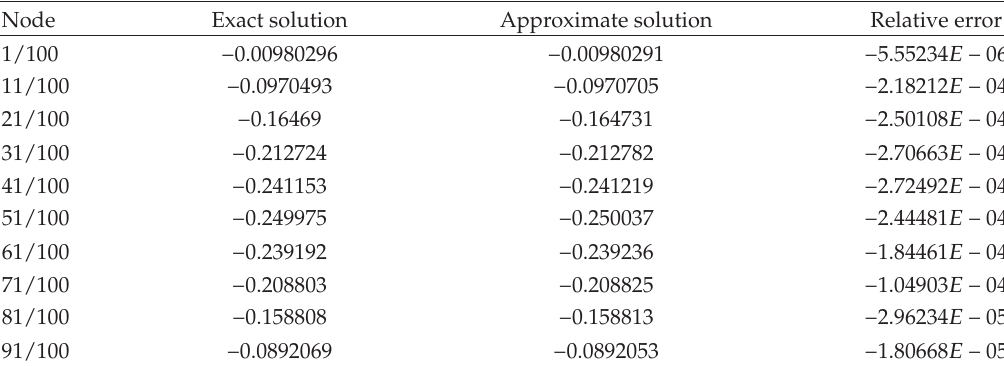
Table 1: Comparison of the errors of u (cid:2) x (cid:3) and U 1 (cid:2) x (cid:3) . Node Exact solution Approximate solution Relative